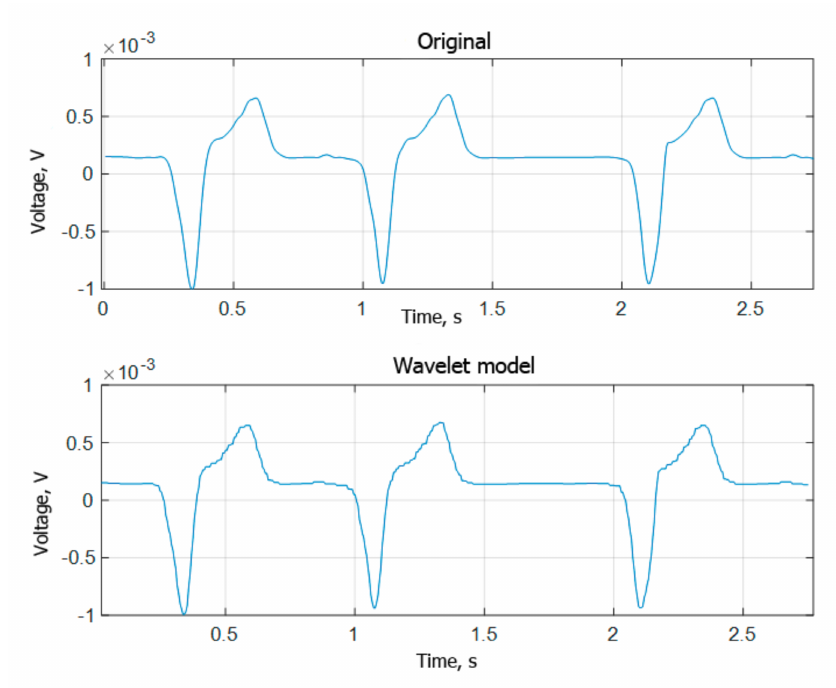
Figure 4. Voltage V2 of the electrocardiosignal after implantation: original and wavelet